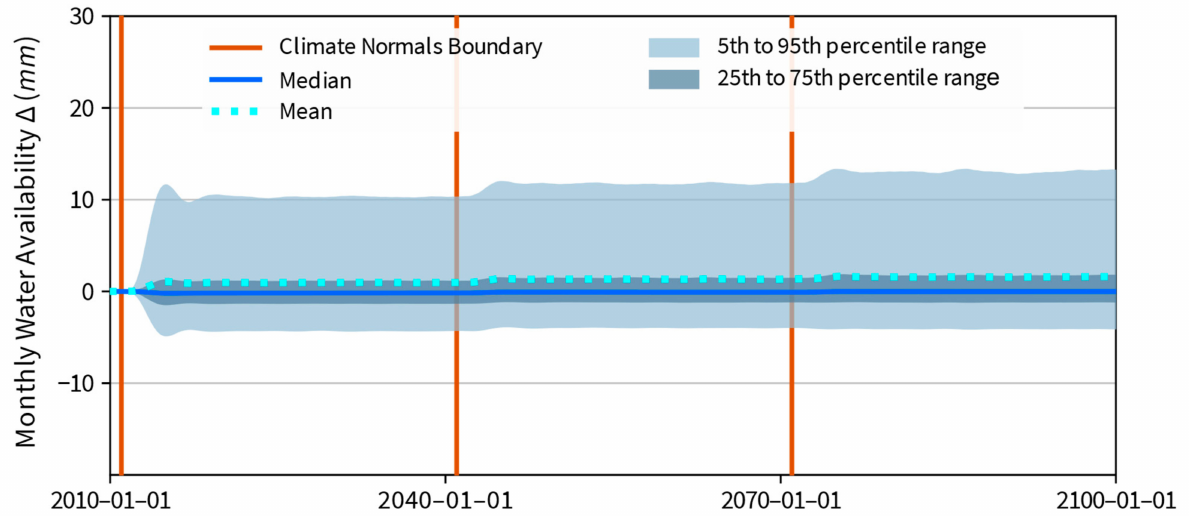
Figure 8. Magnitude of change in water availability and associated likelihood from the CC scenario. Median expected change is essentially zero. The interquartile range spans from negative to positive values and is narrow compared to the 5th–95th percentile range. Average annual precipitation is forecast to be unchanged for future conditions; consequently, median water availability ∆ is near zero. An increase in future extreme event intensity is incorporated into the future climate change representation and is responsible for the positive bias in the 5th–95th percentile water availability ∆ range and the slight increase in average water availability ∆ . Average mean water availability ∆ during 2071–2100 is 1.6 mm and average median water availability ∆ is 0.0 mm.